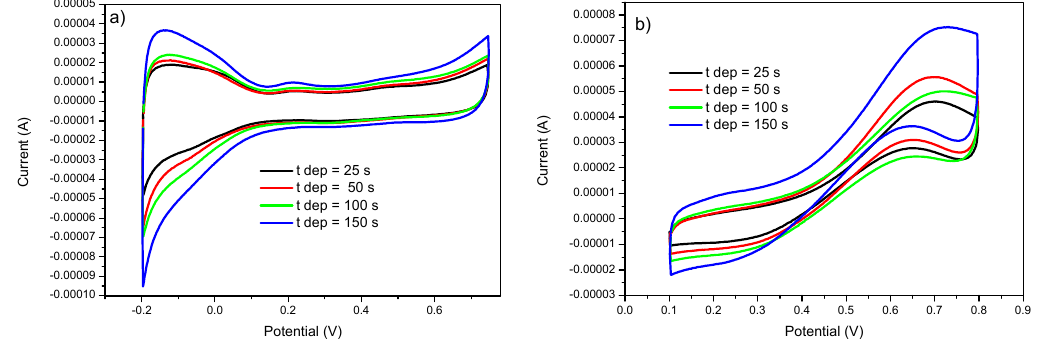
Figure 8. Cyclic voltammetry in 0.5 M H 2 SO 4 ( a ) and in 2 M methanol + 0.5 M H 2 SO 4 ( b ) of GC/PANI(CV)/PtNPs electrodes obtained at various deposition times (t dep ) = 25, 50, 100, and 150